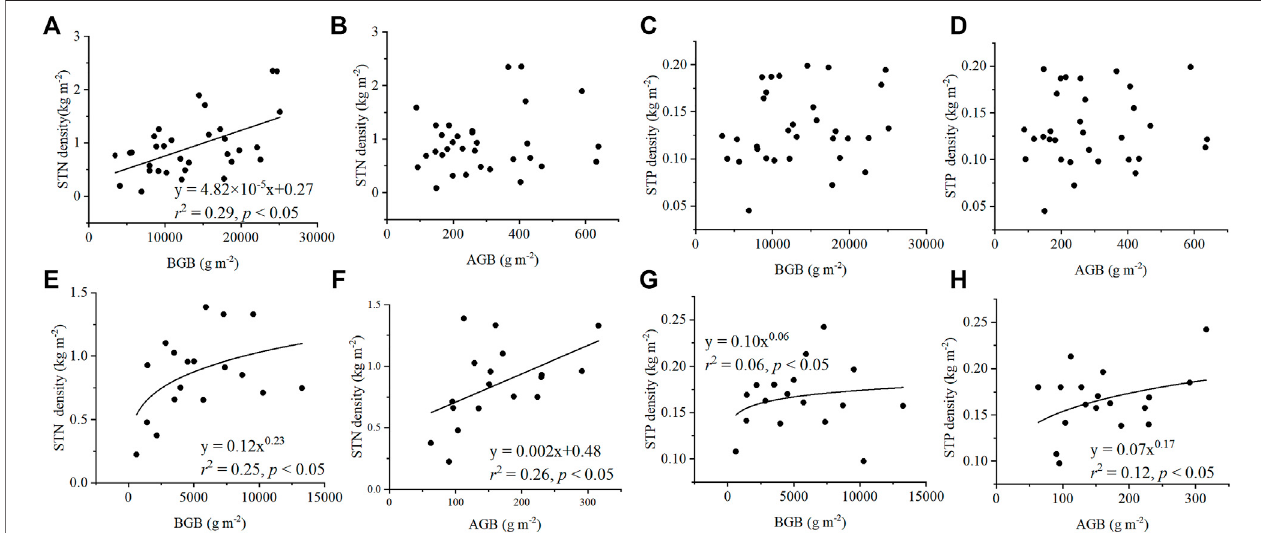
FIGURE 2 | Relationships of STN density and STP density with plant variables, including AGB and BGB. The relationships of STN density in alpine wetlands (A,B) and alpine meadow (E,F) with BGB (A,E) and AGB (B,F) . The relationships of STP density in alpine wetlands (C,D) and alpine meadow (G,H) with BGB (C,G) and AGB